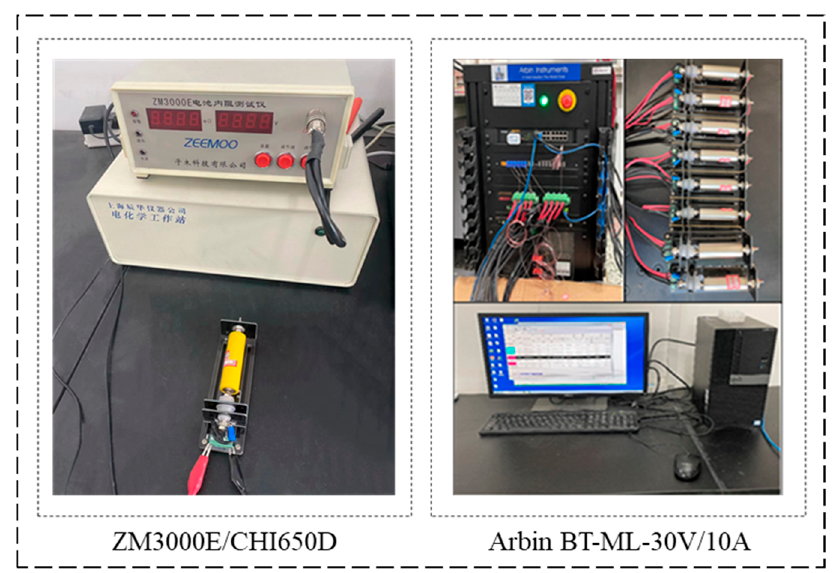
Figure 7. Battery experimental platform.